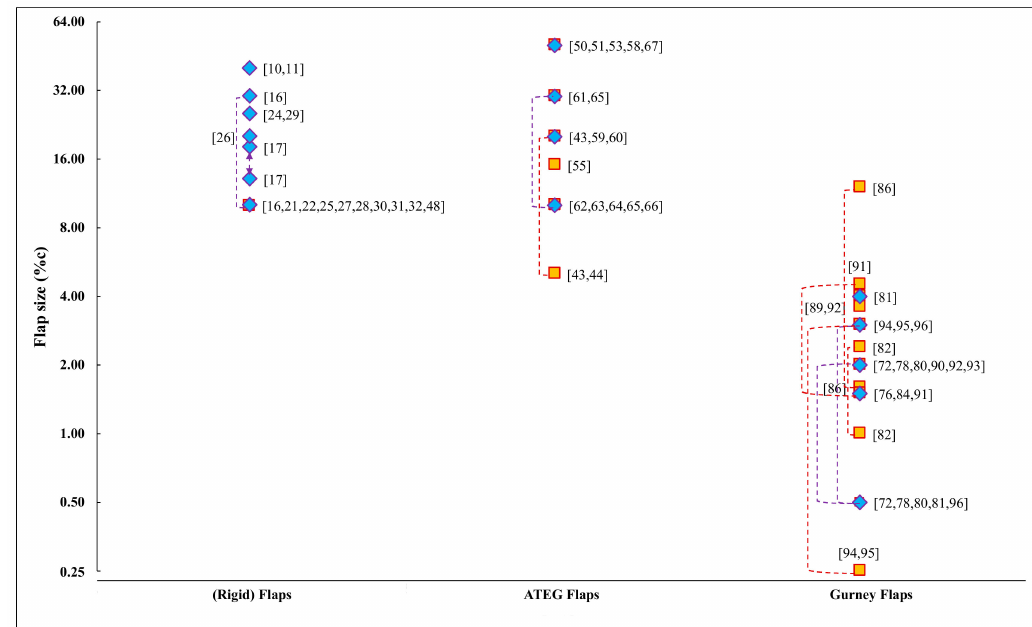
Figure 5. Literature survey of rigid, adaptive (ATEG), and gurney flaps. (The empty and filled markers correspond to the numerical and experimental investigations, respectively. The arrows indicate the range of